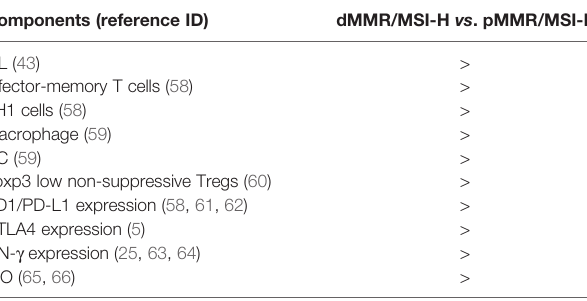
TABLE 1 | Difference of tumor immune microenvironment (TIME) between dMMR/MSI-H CRCs and pMMR/MSI-L CRCs. Components (reference